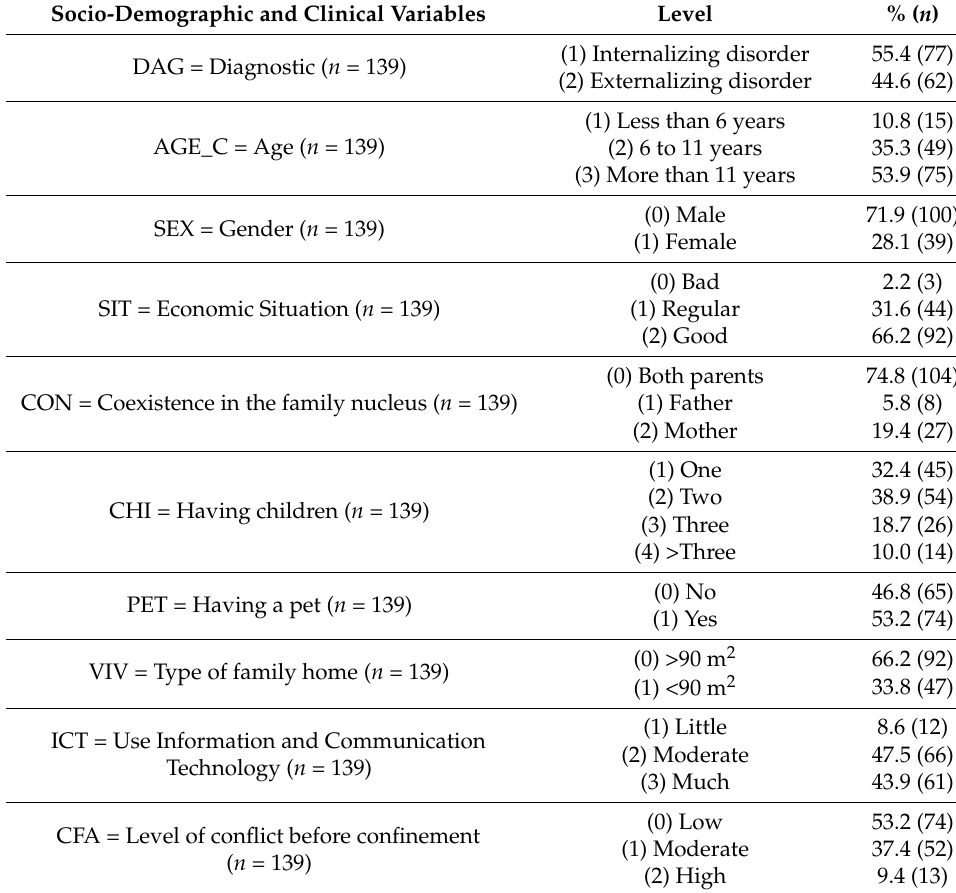
Table 2. Description of the qualitative